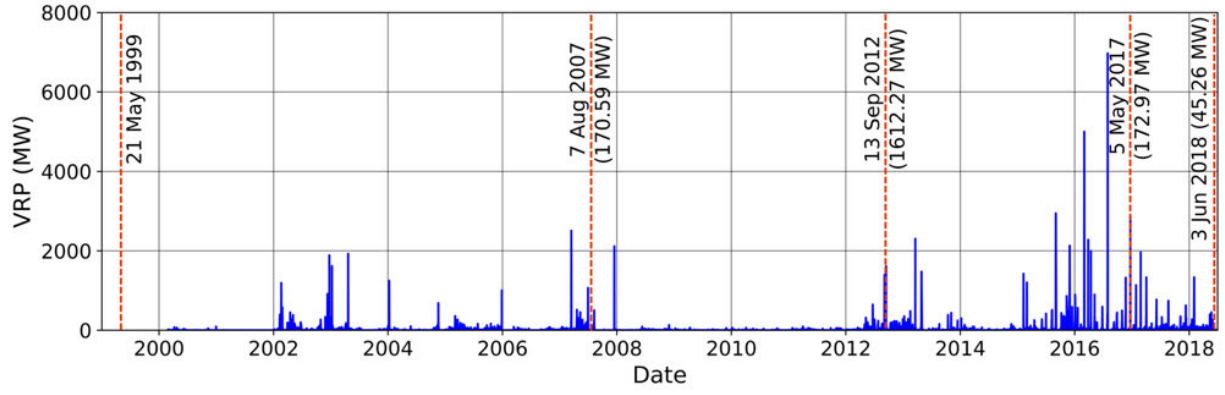
Figure 3: Contrasting local experiences of eruptions with satellite remote sensing observations. Orange dashed lines represent local experiences of major eruptions 1999–2019, while blue timeseries represents satellite-based thermal timeseries data derived from MIROVA night-time values of Fuego activity 2000–2018 (adapted from Naismith et al. [2019]). Each one of the eruptions highlighted by locals is associated with largest MIROVA value for that eruption, where possible.